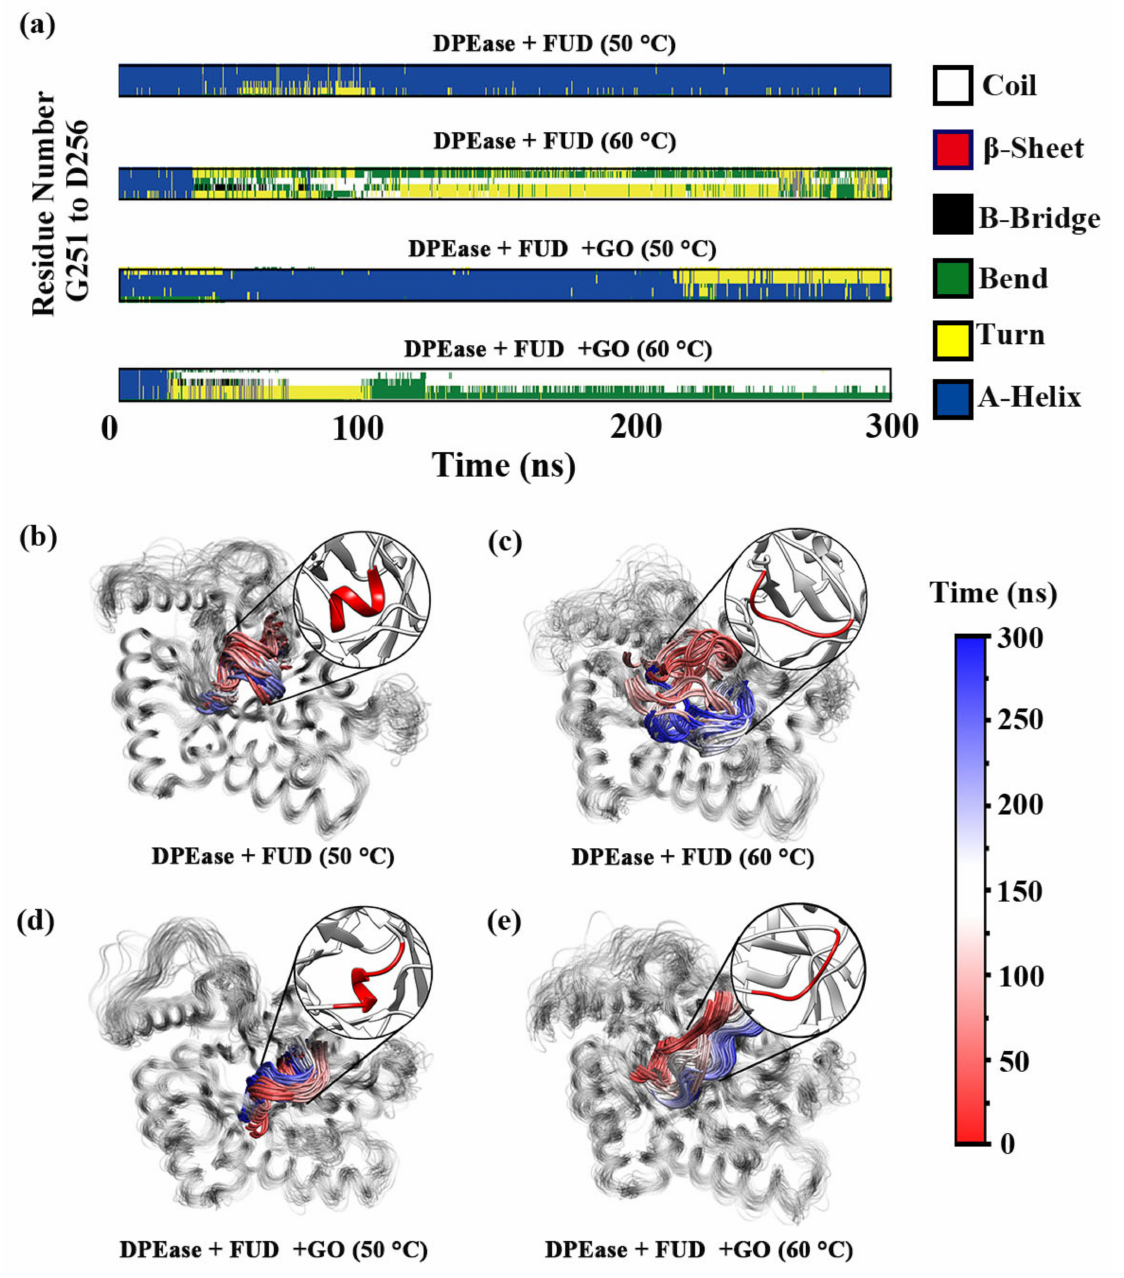
Figure 7. ( a ) DSSP results of α 8 (cid:48) residues; α 8 (cid:48) region is colored mapped from red (0 ns) through white and to blue (300 ns) along with time for ( b ) DPEase + FUD (50 ◦ C); ( c ) DPEase + FUD (60 ◦ C); ( d ) DPEase + FUD + GO (50 ◦ C); ( e ) DPEase + FUD + GO (60 ◦